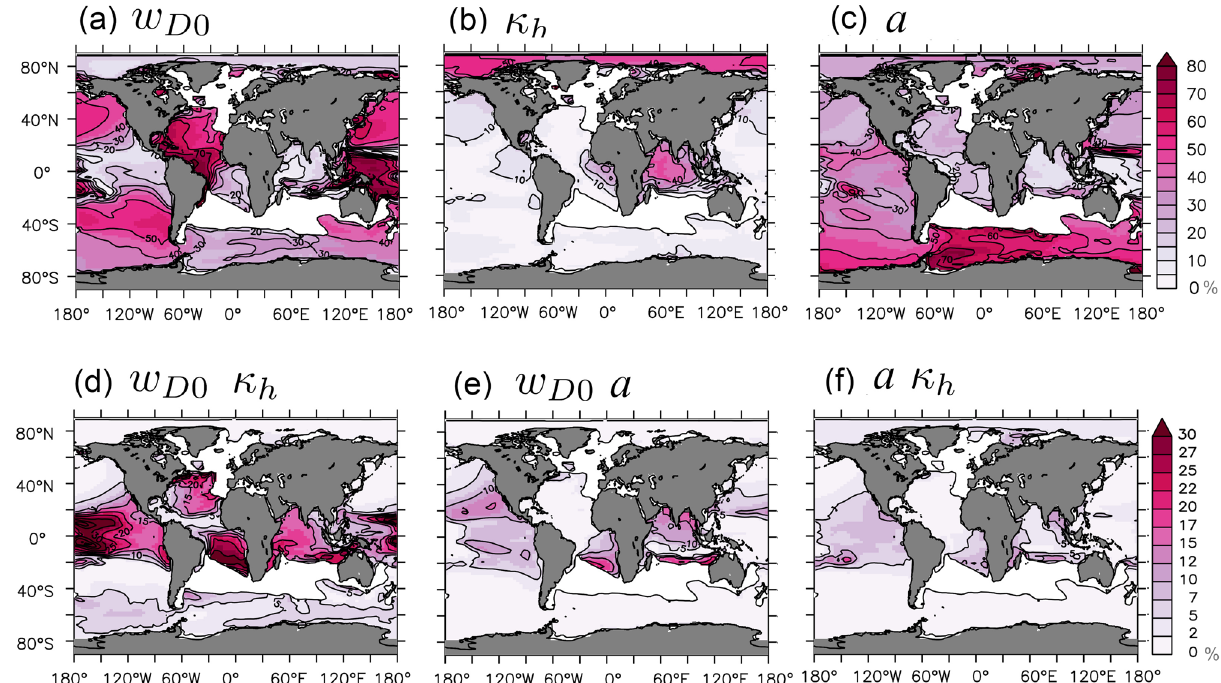
Figure 3. Variance-based sensitivity-analysis 20 of the simulated minimal oxygen content in the water column in the year 2000. Panel ( a – c ) show the main effects for the considered model parameters (sinking speed of organic matter w , vertical background ocean mixing, κ , and maximum phytoplankton growth, a , resp.) and ( d – f ) illustrate the interactions. Regions where the overall variance is very small (standard deviation below 6% of the mean value) are masked out in white. This figure was created with PyFerret v7.5 (https:// ferret. pmel. noaa. gov/ Ferret/ docum entat ion/ pyfer